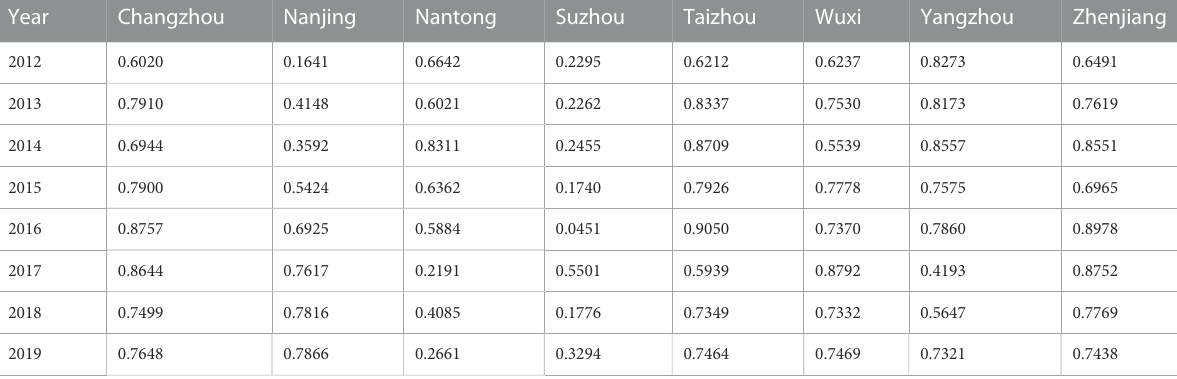
TABLE 3 Water environment carrying status index of eight cities along the Yangtze River in Jiangsu province from the horizontal year view by the projection pursuit method. Year